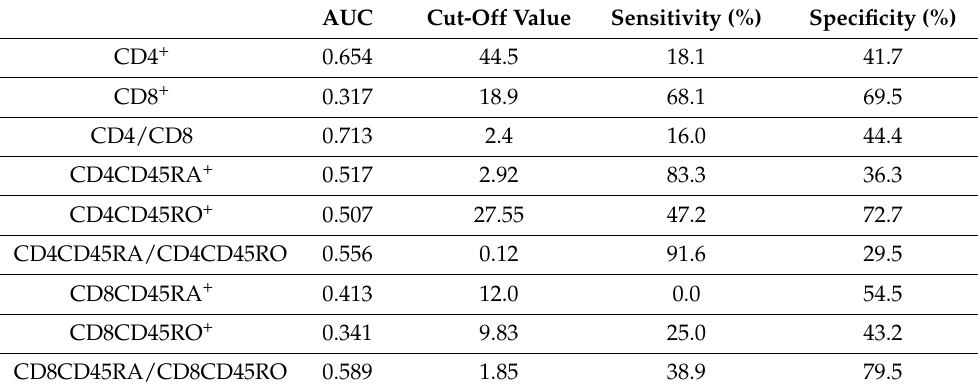
Figure 2. The immune risk profile (IRP) expressed as the ratio of total CD4 + to total CD8 + in low- grade inflammation group ( A ) and high-grade inflammation group ( B ) differentiated to reference ranges for CD4/CD8 (normal ≥ 1 or ≤ 2.5, inverted < 1, high > 2.5). Table 8. The statistical characteristics of the ROC curve for the univariate logistic model for T lymphocyte